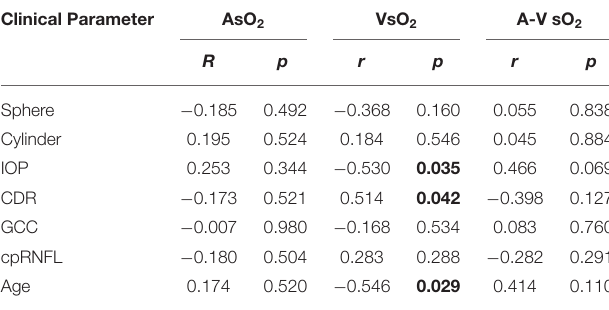
TABLE 3 | Correlation between clinical parameters and vessel sO 2 based on